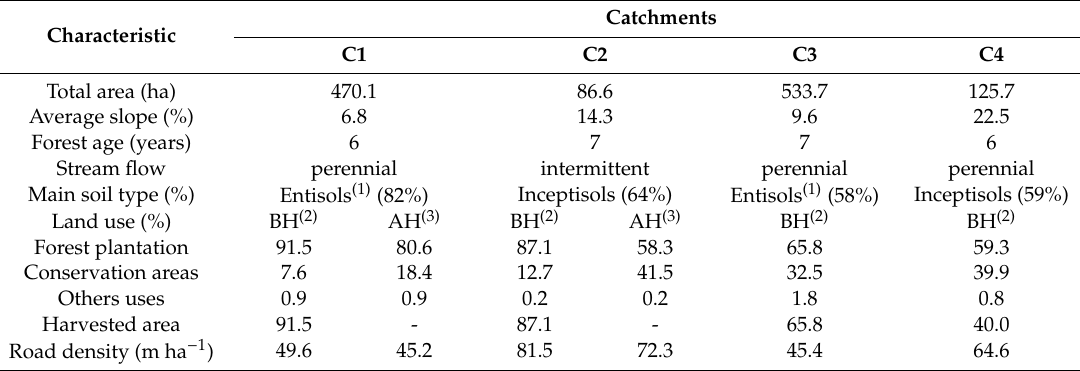
Table 1. Main characteristics and distribution of land use on catchments C1, C2, C3 and C4.